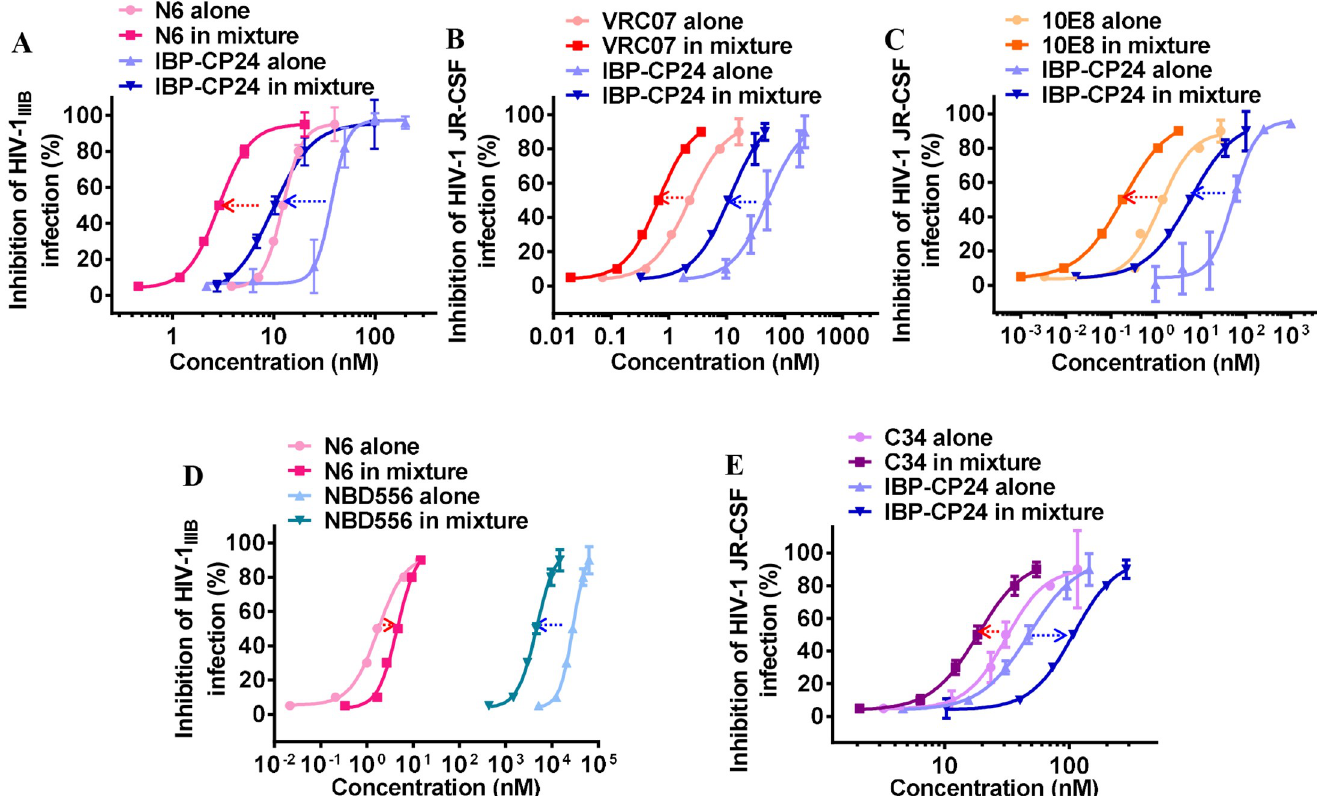
Fig 8. Synergistic effect of IBP-CP24 combined with bNAbs against HIV-1 infection in vitro . (A) The inhibitory activities of N6 alone, IBP-CP24 alone, or N6/ IBP-CP24 combination against HIV-1 IIIB infection. (B) The inhibitory activities of VRC07 alone, IBP-CP24 alone, or VRC07/IBP-CP24 combination against HIV-1 JR-CSF infection. (C) The inhibitory activities of 10E8 alone, IBP-CP24 alone, or 10E8/IBP-CP24 combination against HIV-1 JR-CSF infection. (D) The inhibitory activities of N6 alone, NBD556 alone, or N6/NBD556 combination against HIV-1 IIIB infection. (E) The inhibitory activities of C34 alone, IBP-CP24 alone, or C34/ IBP-CP24 combination against HIV-1 JR-CSF infection. Each sample was tested in triplicate and data were presented as mean ± SD.